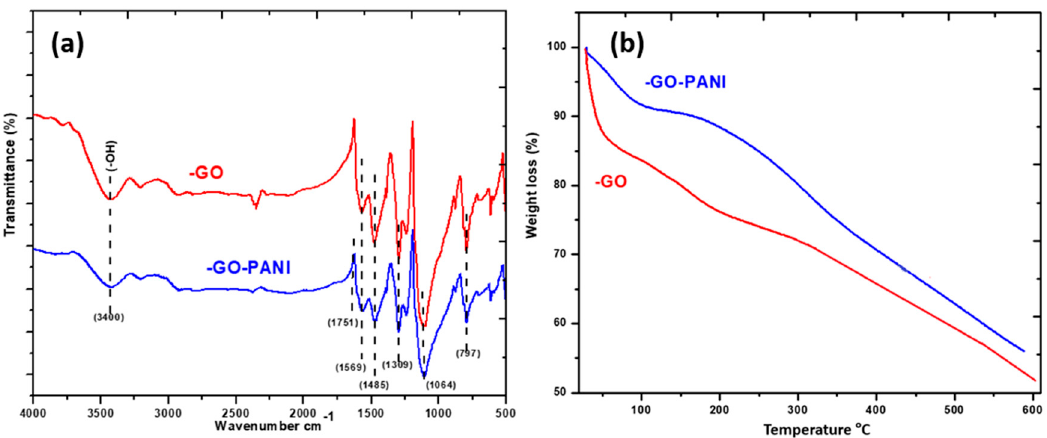
Figure 2. ( a ) Fourier-transform infrared spectroscopy (FT-IR) spectra and ( b ) thermal gravimetric analysis (TGA) spectra of GO and GO-PANI nanocomposite.